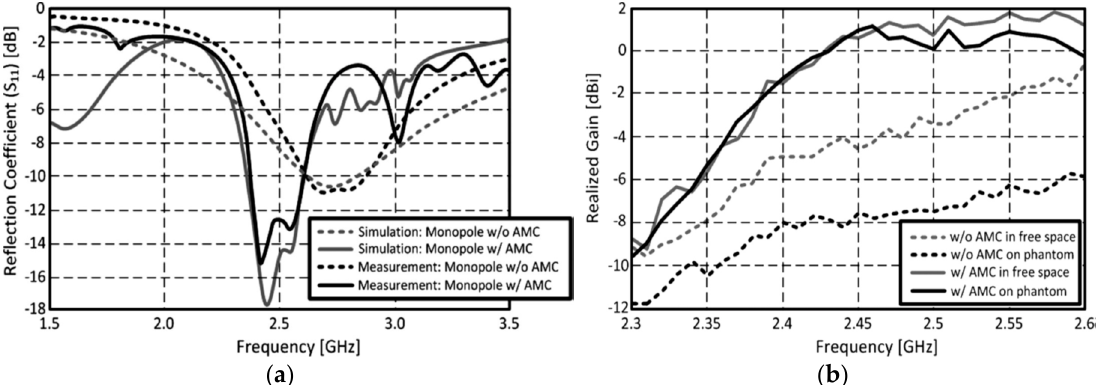
Figure 19. Measured antenna performance parameters: ( a ) Reflection coefficient (| S 11 |) and ( b ) gain.